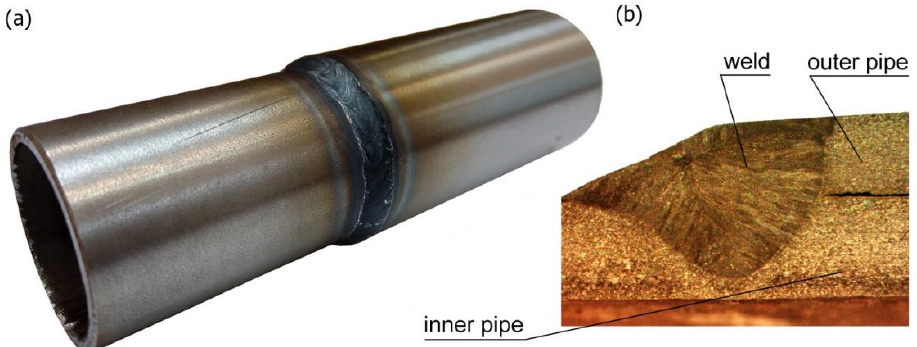
Figure 2. A circumferentially welded pipe of different diameters: ( a ) general view, ( b ) macroscopic view of the cross-section of the weld.